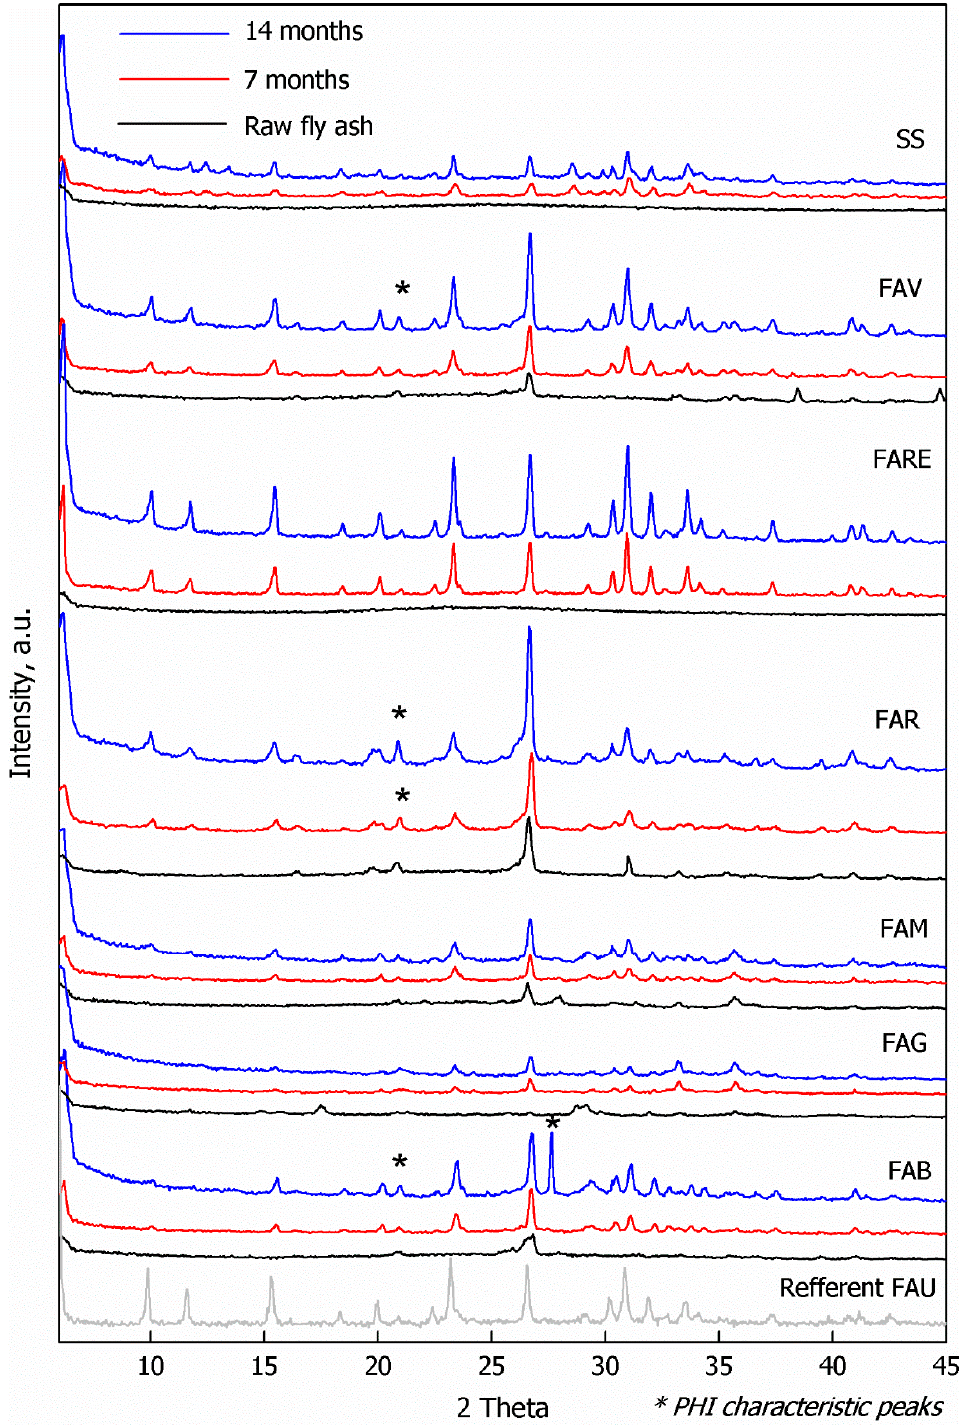
Figure 1. X-ray di ff raction patterns of raw fly ashes and synthesized samples after 7 months (red Figure 1. X-ray diffraction patterns of raw fly ashes and synthesized samples after 7 months (red spectra) and 14 months (blue spectra) of quasi-natural spectra) and 14 months (blue spectra) of quasi-natural crystallization.